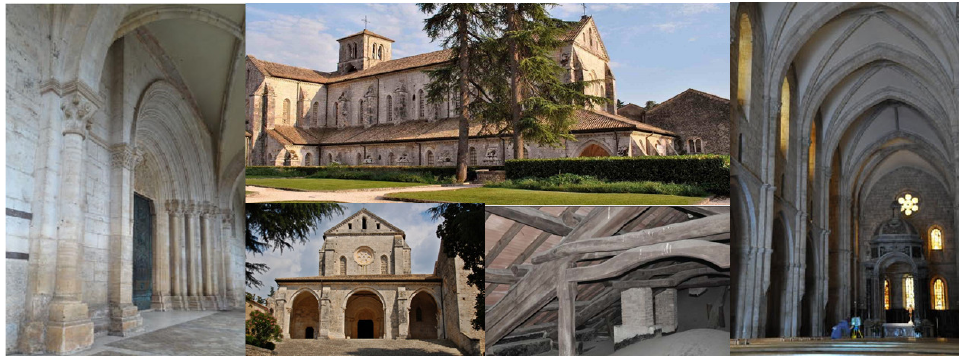
Figure 1. The Casamari Gothic church: church façade, an interior view and details of timber roof.